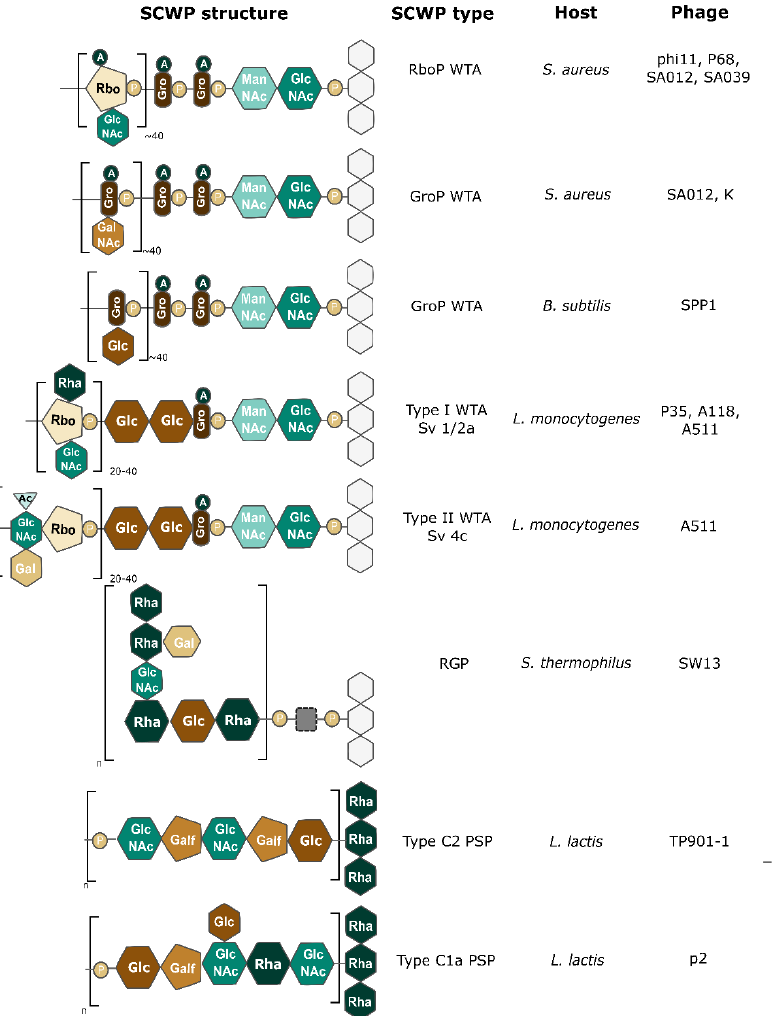
Figure 2. Example of secondary cell wall polysaccharides acting as phage receptors. Some SCWP structures are shown on the left with their corresponding SCWP types. The bacterial species in which each SCWP is found are shown on the right, together with one or several examples of phages using these SCWP as receptors. A: D -alanine; P: phosphate; Ac: acetylation. Glycosyl residues: Gal: galactose; GalNAc, N -acetylgalactosamine; Glc: glucose; Gro: glycerol; ManNAc, N -acetylmannosamine; Rbo, ribitol; Rha: rhamnose. SCWP: Secondary Cell Wall Polysaccharide; WTA: Wall Teichoic Acid; LTA: Lipoteichoic Acid; PSP: polysaccharide pellicle; RGP: Rhamnose Glucose polysaccharide. Gray squares indicate unclear linkage units. White hexagons represent PG. In L. lactis PSP are not directly linked to PG but rather to Rhamnose polysaccharides, which are attached to PG. Repeat units are indicated in brackets with numbers representing the number of repeats found in each SCWP, and n referring to an unknown number of repeats. This figure was made with Inkscape, with information from [40,66,70 – 72].